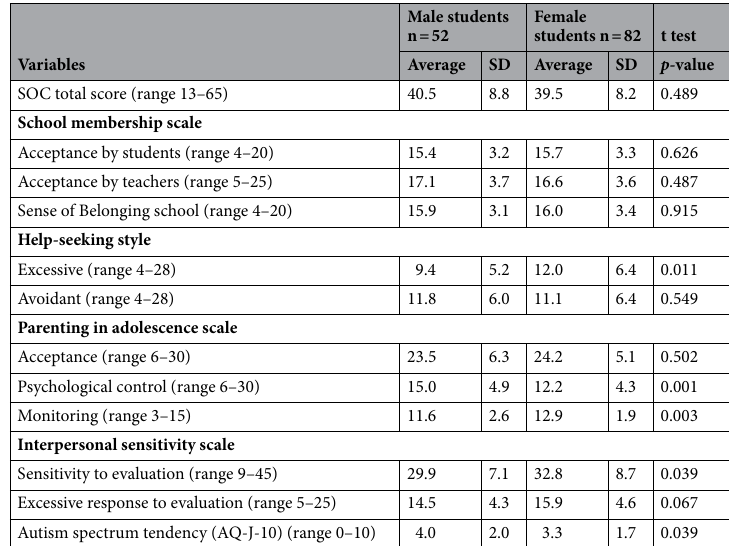
Table 3. Comparison of scale average by students’ gender. SOC sense of coherence.